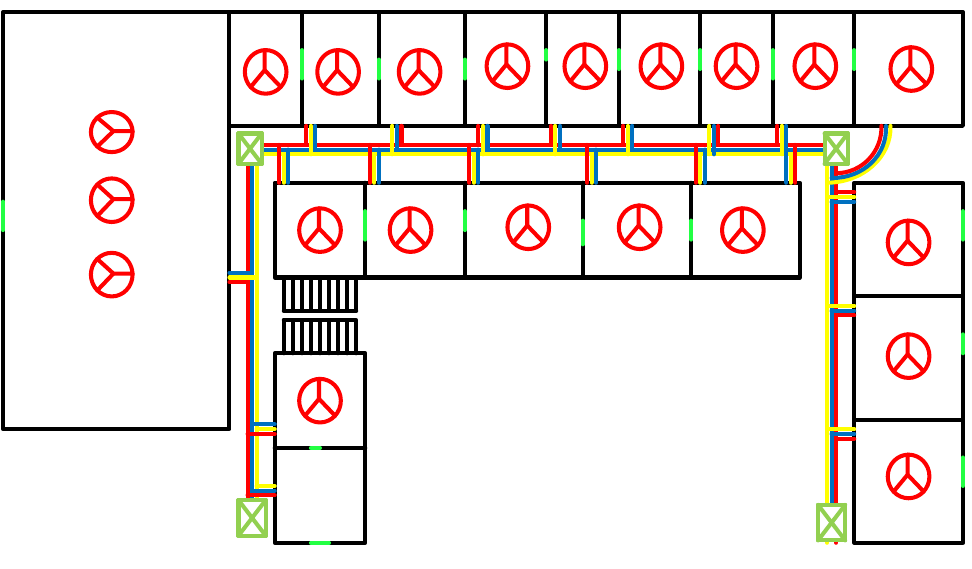
Figure 4. Sketch of the Faqir API Hostel (ground floor).